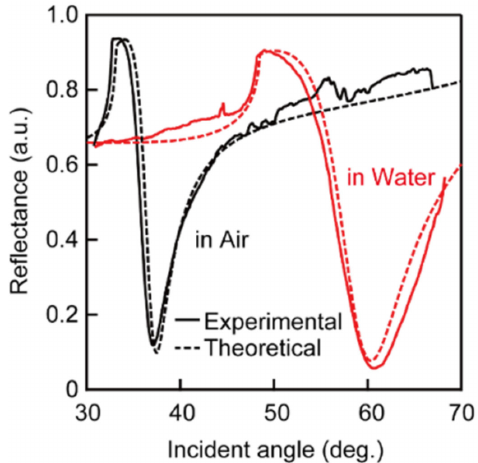
Figure 3. Experimental (solid) and theoretical (broken) reflectance dependences on the incident angle in air and in